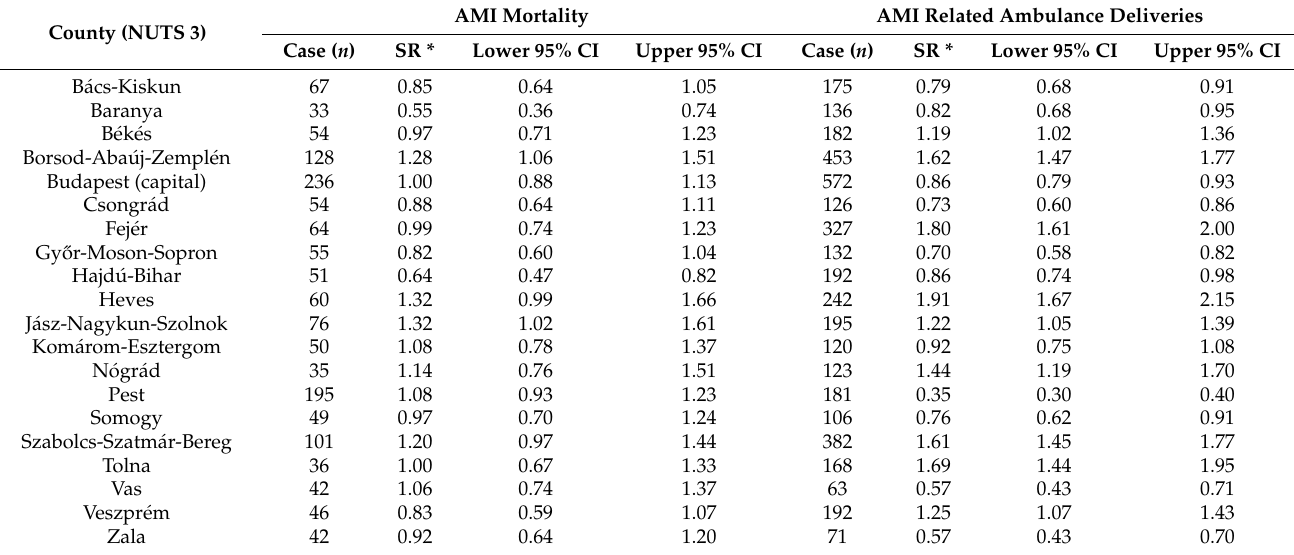
Table 2. AMI mortality and AMI-related ambulance deliveries in Hungary, 2018.